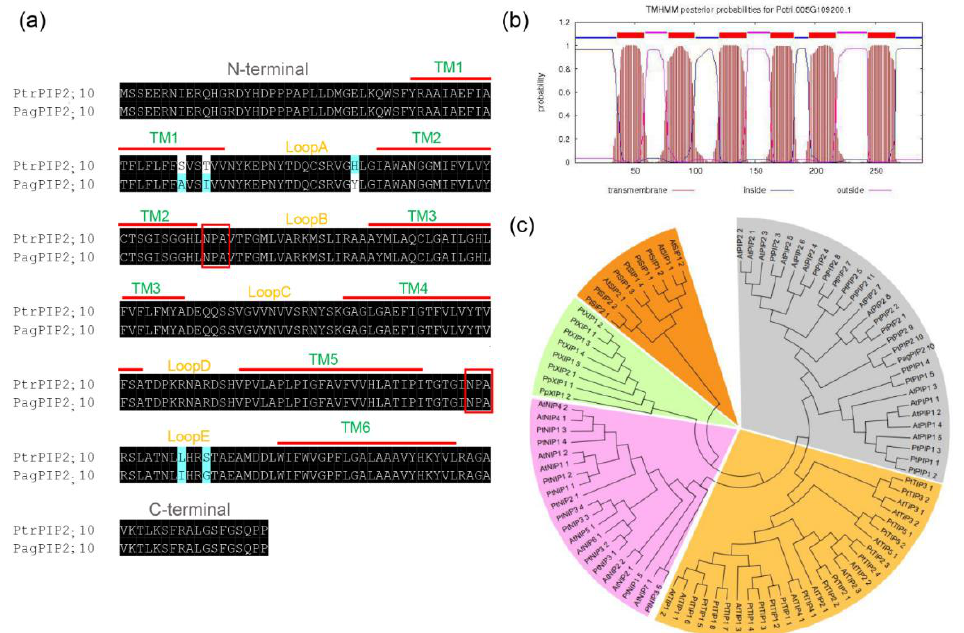
Figure 1. Sequence analysis of PagPIP2;10. ( a ) Sequence alignment PtrPIP2;10 and PagPIP2;10; ( b ) Transmembrane secondary structure of the PagPIP2;10 protein predicted using TMHMM, TMD 1–6 and loops A–E, with two NPA domains (highlight with red color) in loops B and E, respectively; ( c ) Phylogenetic tree of PagPIP2;10, AtPIPs, and PtrPIPs. 3.2. Expression Pattern of PagPIP2;10 in Different Tissue and in Response to Osmotic Stress